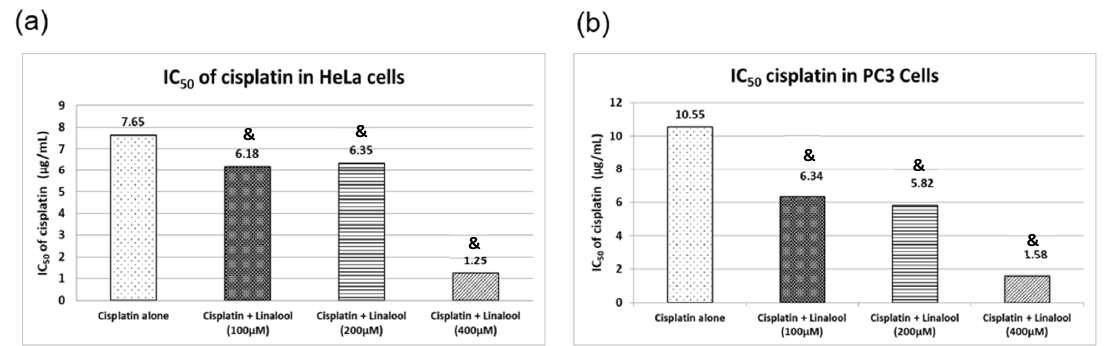
Figure 8. Cytotoxicity actions of c isplatin alone or in combination with di ff erent concentrations of linalool in HeLa ( a ) and PC3 ( b ) cancer cell lines. All values are expressed as mean ± SD. All values are expressed as mean ± SD. The symbol “&” indicates statistically significant from cisplatin-only group ( p < 0.05) using one-way ANOVA followed by Tukey’s post-hoc